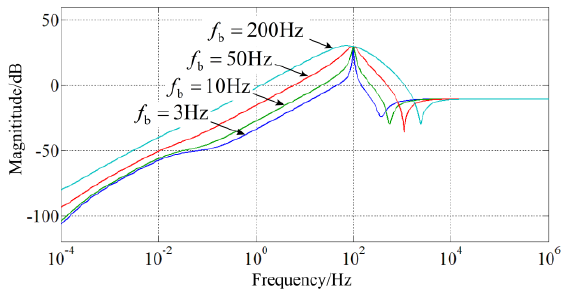
Figure 9. Magnitude plots of Z Lv_NICFPS (s) with different f b .